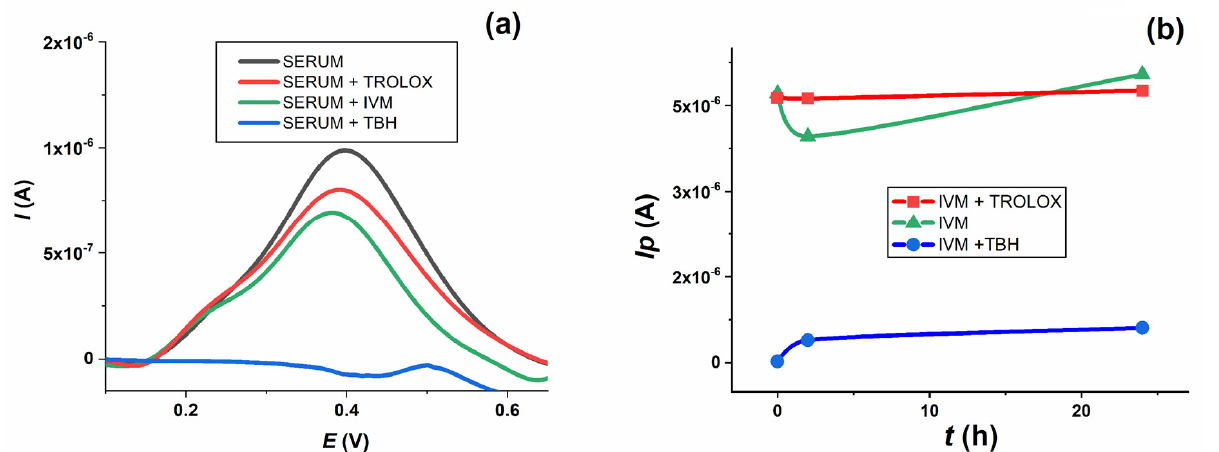
Figure 10. ( a ) Baseline corrected DPV of blank human serum oxidation, immediately ( ── ) and after addition of Trolox ( ── ), IVM ( ── ) and TBH ( ── ) after 24 h of incubation. ( b ) Change in oxidation peak current of IVM during 24 h of incubation in human serum ( ── ), and human serum with added Trolox ( ── ) and TBH ( ── ).